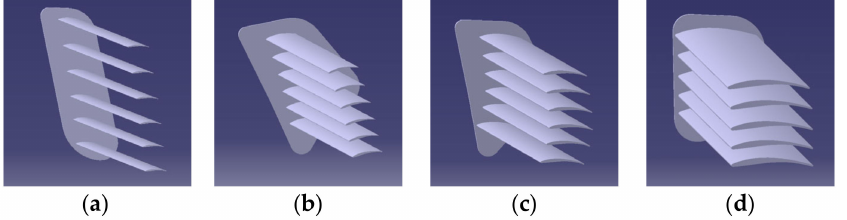
Figure 13. CAD models of different shutters with distinct fin chord length. ( a ) Shutters with chord length L = 30 mm. ( b ) Shutters with chord length L = 60 mm. ( c ) Shutters with chord length L = 90 mm. ( d ) Shutters with chord length L = 150 mm. Table 4. Simulation results of fin chord length optimization (15